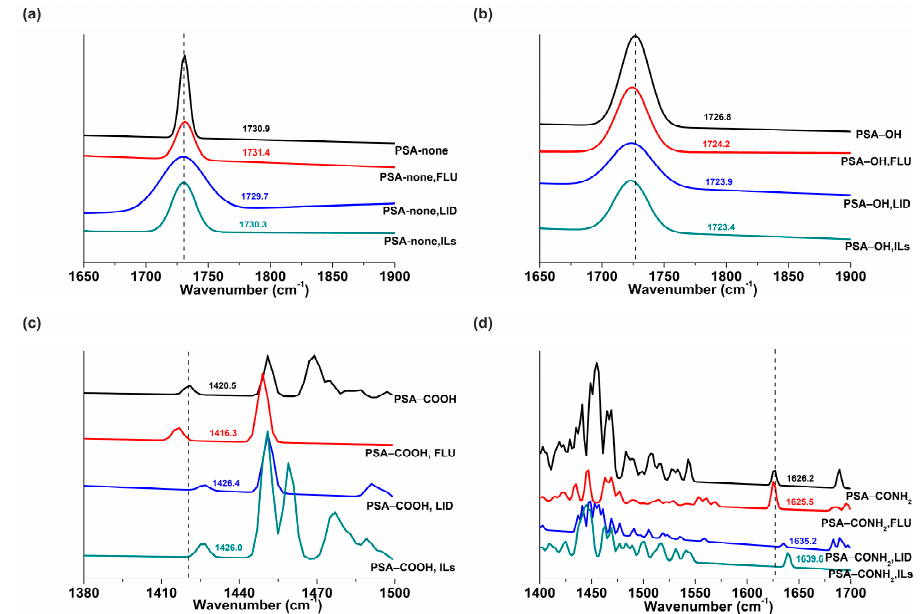
Figure 8. Raman spectra in C=O stretching vibration peak for the PSA − none ( a ) and PSA − OH ( b ), O − H out-of-plane bending vibration peak of COOH for the PSA − COOH ( c ), the N − H stretching vibration peak for the PSA − CONH 2 ( d ).